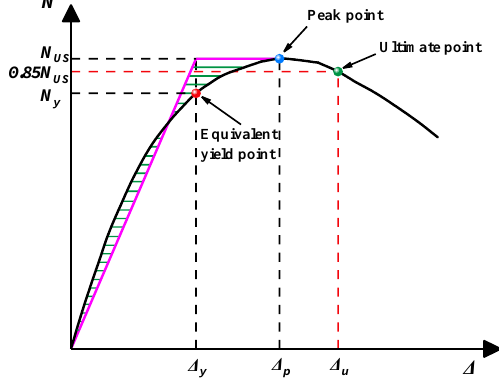
N - ε curves, K and µ of EGCSSCs with different f cc are shown in Figures 7,8. As seen in Figure 7, when the values of f cc are given from 38.5 to 44.5 and 50.2 MPa, the ultimate axial-bearing capacity ( N us ) of specimens with the cross-section height of 800 mm could